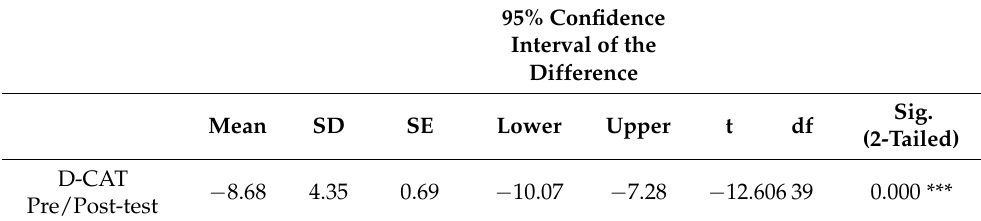
Table 5. Paired sample test of D-CAT.